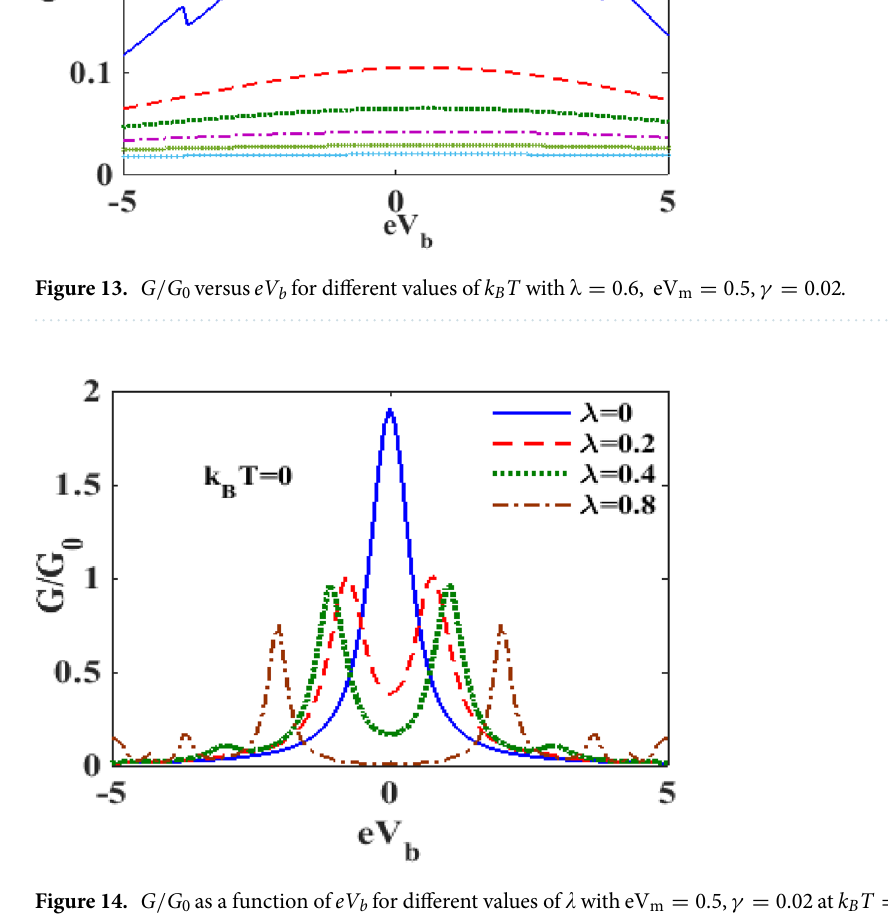
Figure 14. G / G 0 as a function of eV b for different values of (cid:31) with eV m = 0.5, γ = 0.02 at k B T = 0